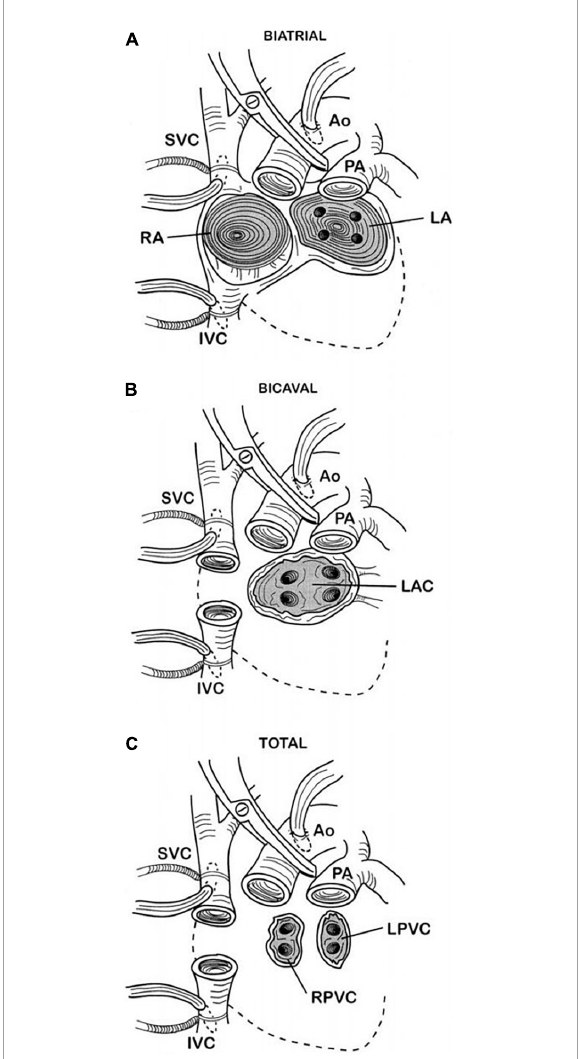
FIGURE1 Surgical techniques for orthotopic heart transplant. Picture (A) shows the biatrial technique in which the anastomoses are at the mid-level of the left and right atria in addition to the aortic and pulmonary artery anastomoses. Picture (B) depicts the bicaval technique, the most commonly used nowadays, in which separate superior and inferior vena cava anastomoses are made instead of the right atrial anastomosis. Finally, picture (C) shows the total orthotopic heart transplant technique, which is a complete atrioventricular cardiac transplantation with separate cava and pulmonary vein anastomoses. Kindly readapted from Badano et al. (16). Dotted lines, original position of excised native heart; Ao, aorta; IVC, inferior vena cava; LA, left atrium; LAC, left atrial cuff; LPVC, left pulmonary vein cuff; PA, pulmonary artery; RA, right atrium; RPVC, right pulmonary vein cuff; SVC, superior vena